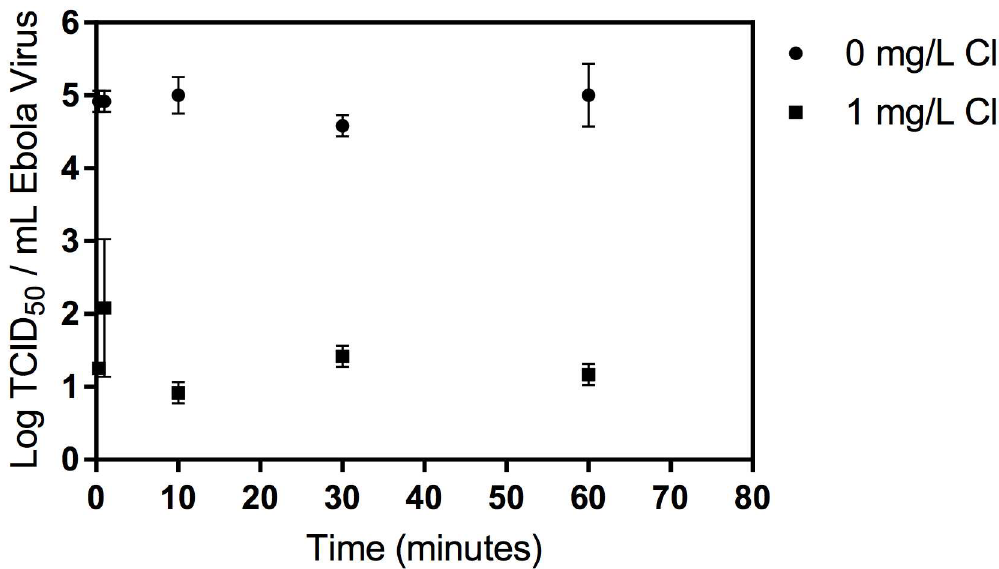
Fig 2. Disinfection of Ebola virus at 0 and 1 mg/L added chlorine. No virus was recoveredfrom the 5 and 10 mg/L chlorineconditionsat any time point. The limit of detectionwas 0.75 log TCID 50 /mL. Error bars represent one standard deviation.